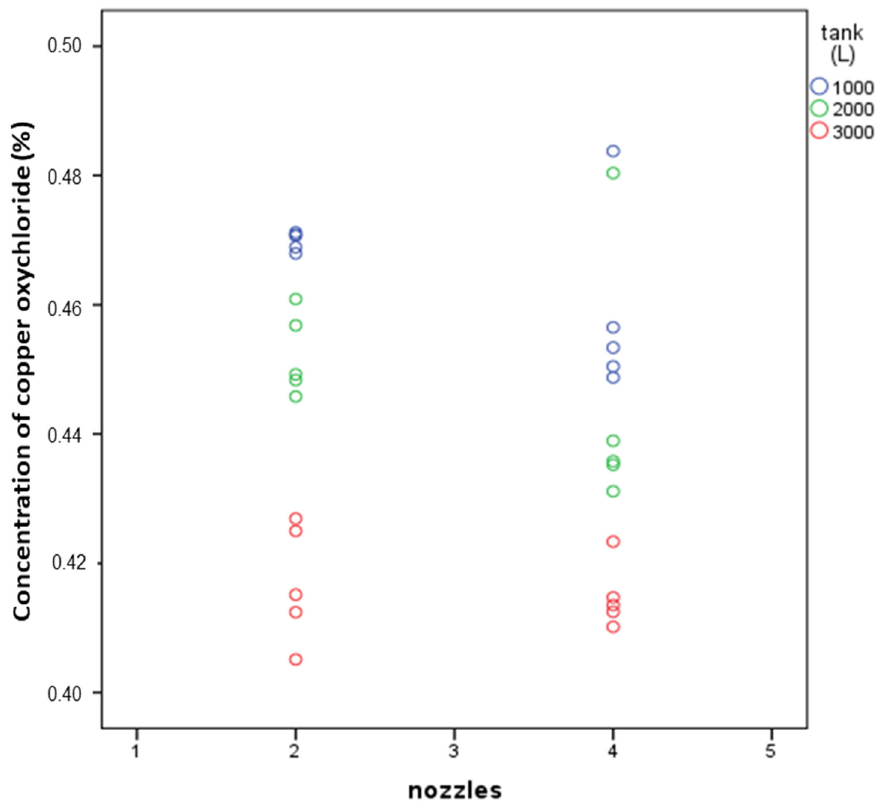
Figure 10. Concentration of copper oxychloride as a function of the number of nozzles and the level of water in the tank. Pressure of the agitation system: 10 bar.